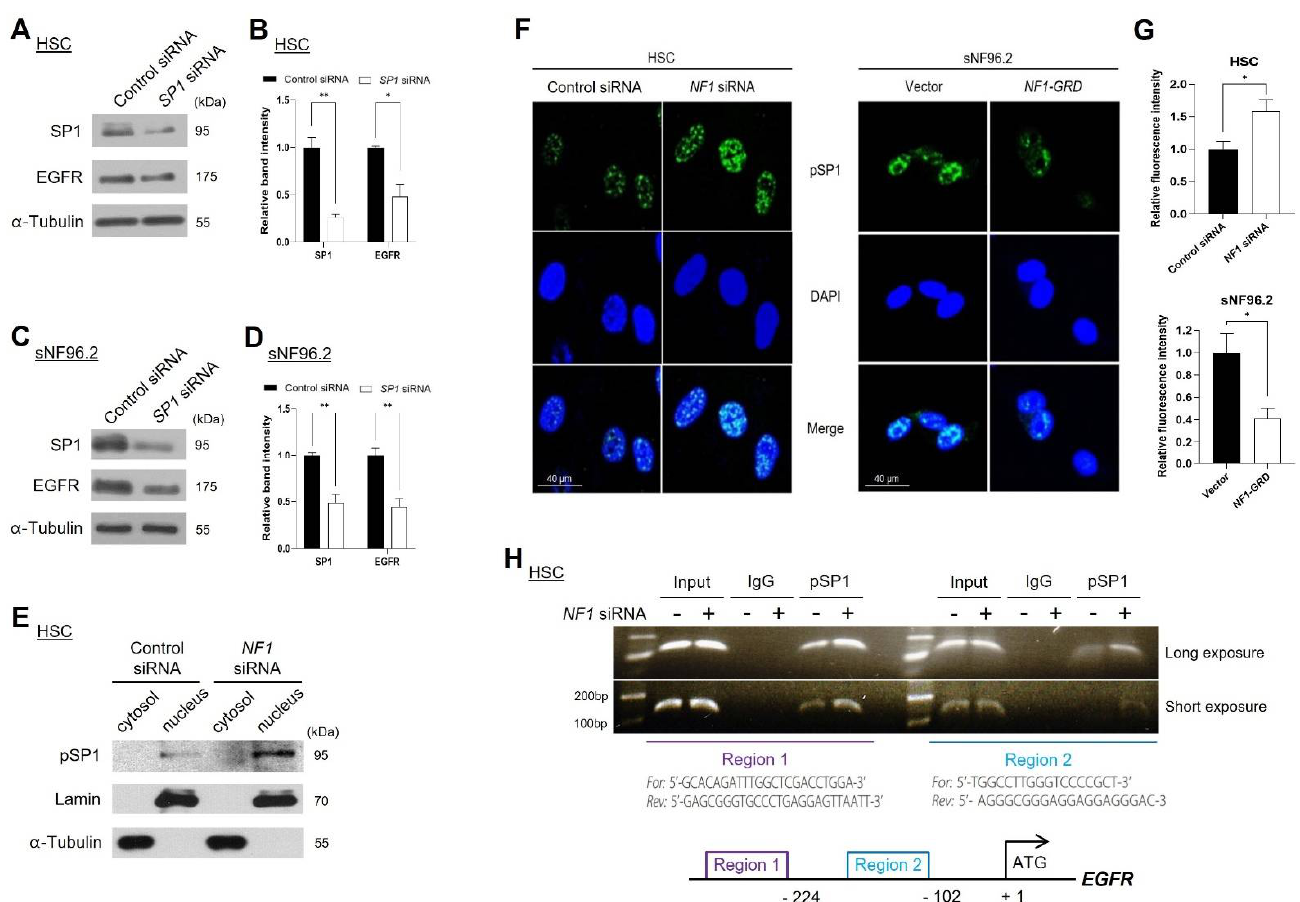
Figure 6. Neurofibromin-mediated regulation of a nuclear localization of phosphorylated SP1 (pSP1) and its binding to the EGFR gene promoter. ( A , C ) Western blot of SP1 and EGFR in HSC and sNF96.2 cells transfected with SP1 siRNA or negative control siRNA. ( B , D ) Immunoblot band density of specific proteins was normalized to the signal intensity of α-tubulin internal control for each sample. The western blot analysis was repeated at least three times with comparable results. Relative band intensity was quantified using ImageJ software. *, p < 0.05 and **, p < 0.01. ( E ) Nuclear or cytoplasmic fractions of transfected HSCs were analyzed by immunoblotting with Lamin (nuclear marker), α-tubulin (cytoplasmic marker), and pSP1 antibodies. ( F ) HSCs were transfected with NF1 siRNA or negative control siRNA, whereas sNF96.2 cells transfected with NF1-GRD . DAPI staining was performed to indicate the positions of nuclei. The cells were analyzed by confocal microscopy with an anti-pSP1 antibody. Scale bar = 40 μm. ( G ) Immunofluorescence for pSP1 (FITC, green) colocalized with DAPI (nucleus, blue) was quantified using ImageJ software. ( H ) ChIP assay was performed in HSCs transfected with NF1 siRNA or negative control siRNA using anti-pSP1 normal rabbit IgG, and positive control. Non-immunoprecipitated chromatin (1%) was used as total input control. ChIP products were amplified by PCR using specific primers for each binding site separately. The same volume of PCR products was separated on a 2% agarose gel and the bands visualized using ethidium bromide staining.